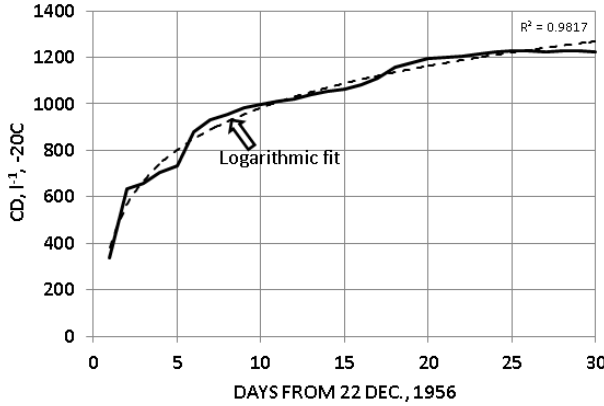
Figure 1. CD in IN concentrations at 26.6 ◦ S, 153.2 ◦ E following a day with 135mm of